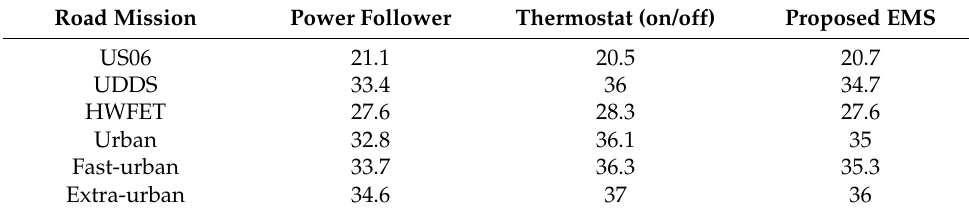
Table 6. Fuel economy